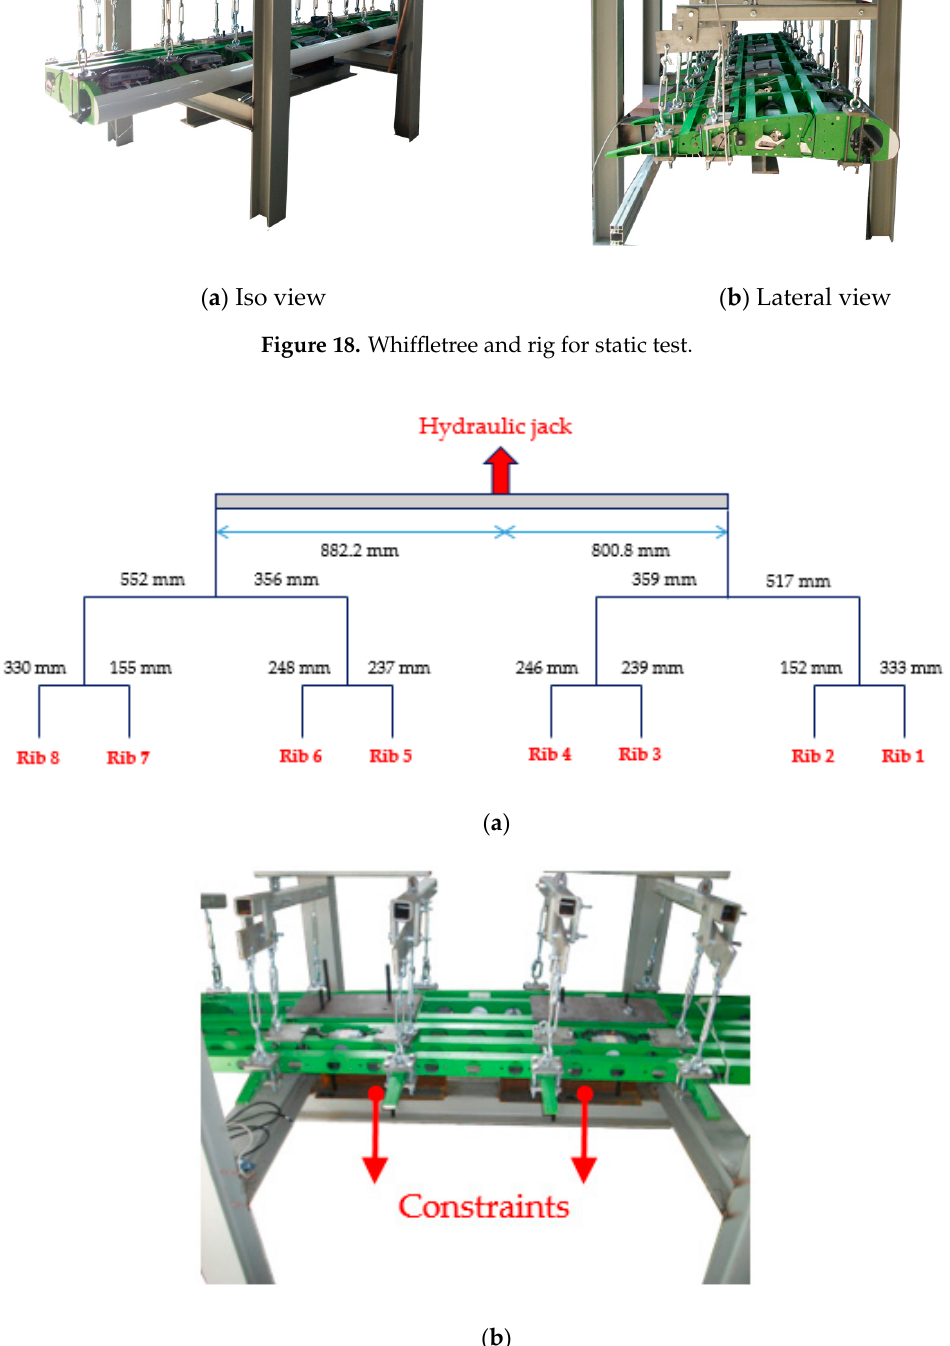
Figure 19. Detail of the load application ( a ) and constraints ( b ) (aft view).